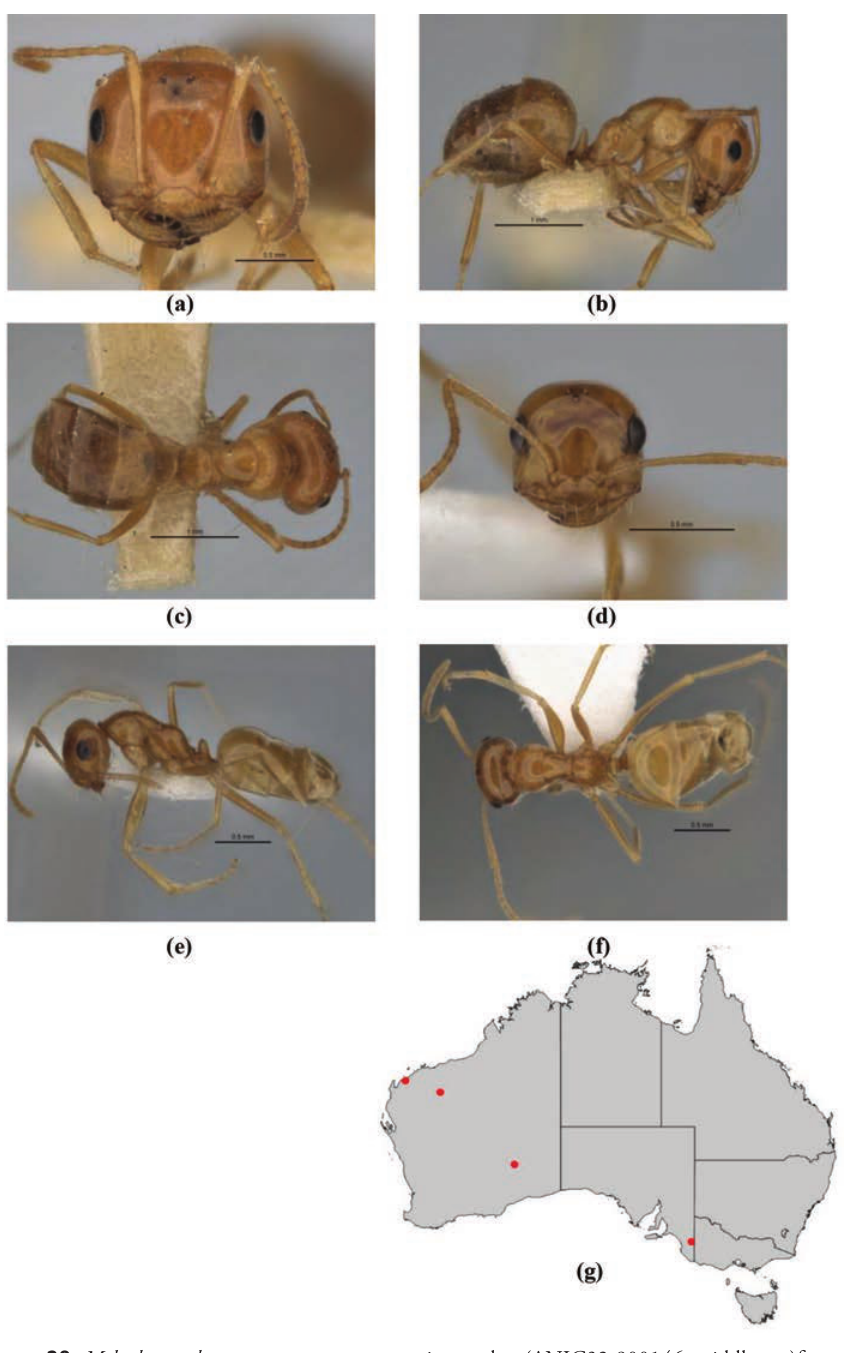
Figure 28. Melophorus chrysus sp. n.: non–type major worker (ANIC32-900146–middle ant)frons ( a ), profile ( b ) and dorsum ( c ); minor worker holotype (JDM32-004655) frons ( d ), profile ( e ) and dor- sum ( f ); distribution map for the species ( g ). Low resolution scale bars: 1 mm ( b, c ); 0.5 mm ( a, d–f